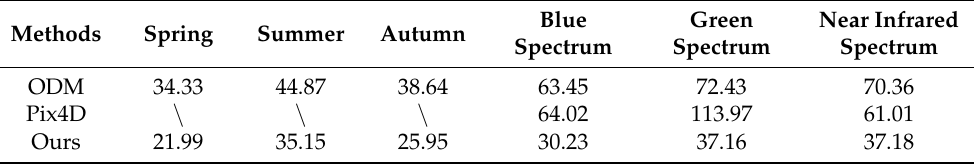
Table 8. Stitching time of two methods on aerial images mosaic